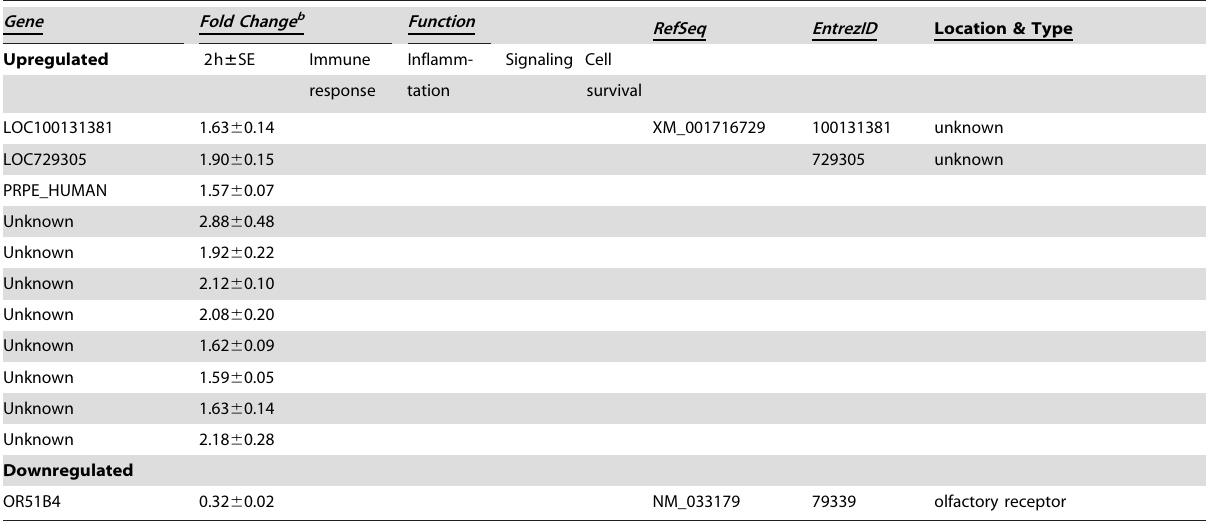
Table S2. Significant genes in mDC induced by cytokine cocktail compared with piDC. Table S3. Bioinformation of novel genes.